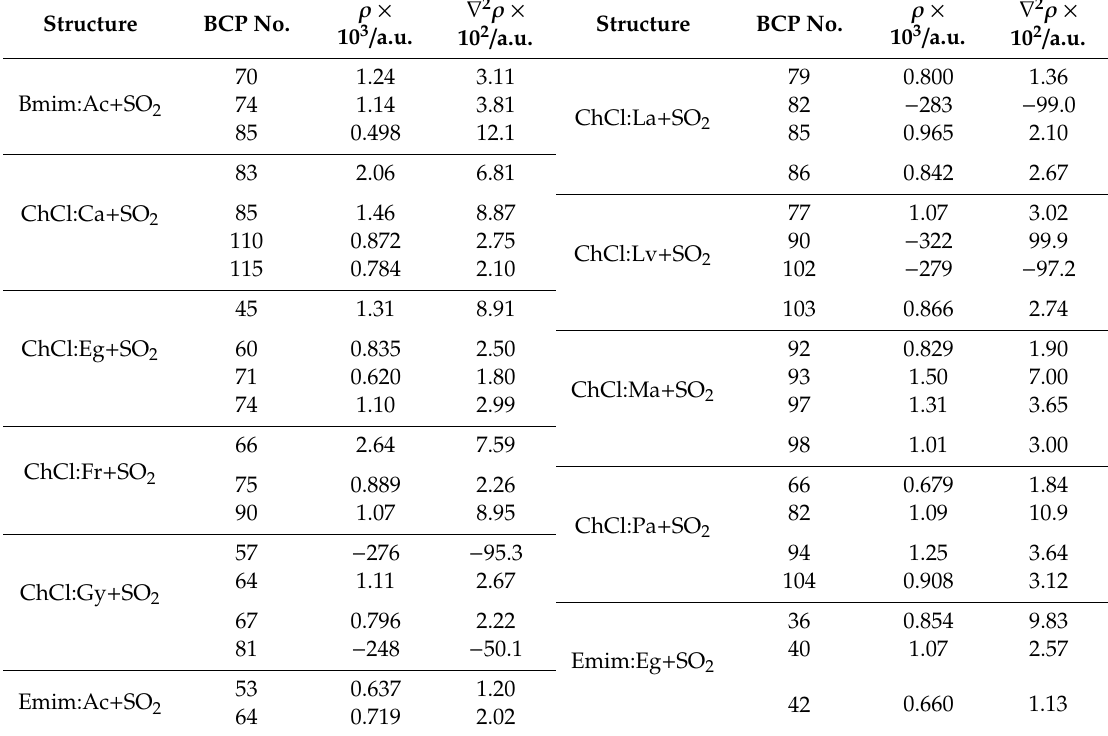
Table 1. Bond critical point (BCP) results for studied structures (Electron density, ρ and Laplacian of electron density, ∇ 2 ρ values are